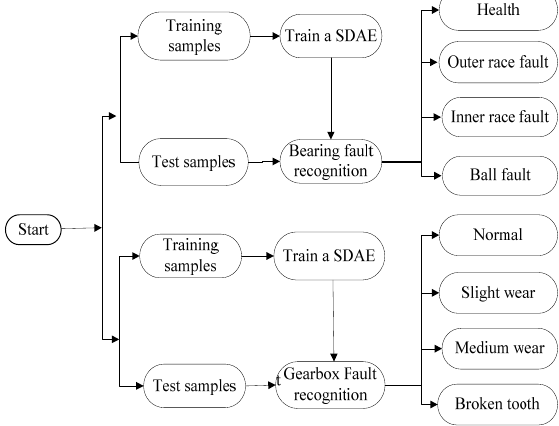
Figure 3. Flow chart of deep fault recognizer.